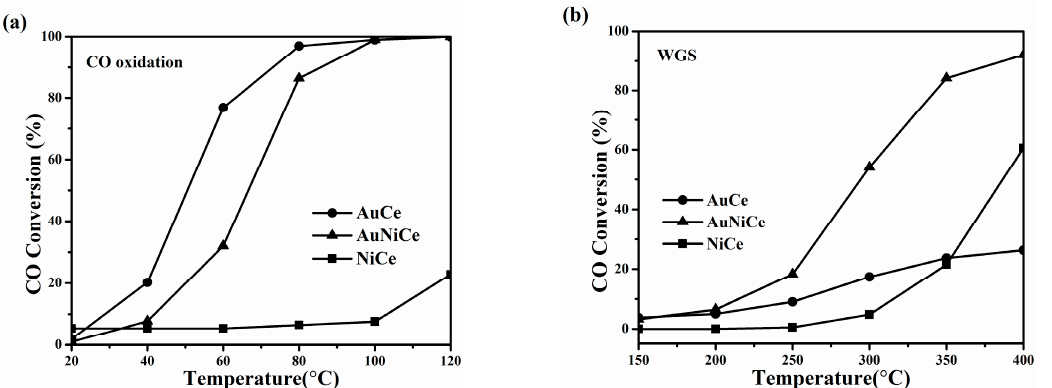
Figure 4. “Light off” profiles of AuNi/CeO 2 samples for: ( a ) CO oxidation reaction (1% CO/20% O 2 /79% N 2 , 80,000 mL g cat − 1 h − 1 ); ( b ) WGS reaction (2% CO/10% H 2 O/88% N 2 , 84,000 mL g cat − 1 h − 1 ).